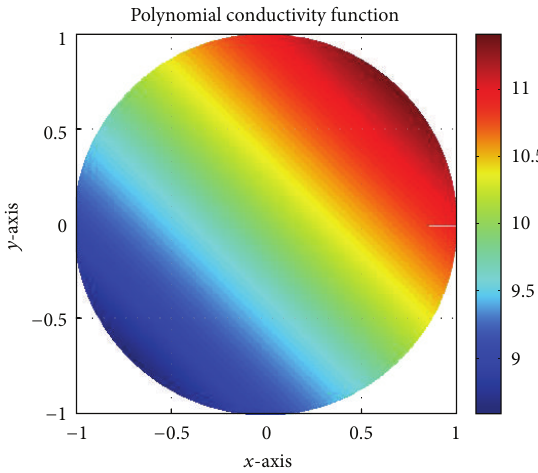
Figure 5: Examples of nonseparable-variables polynomial conduc- tivity function 𝜎 = 𝑥 + 𝑦 + 10